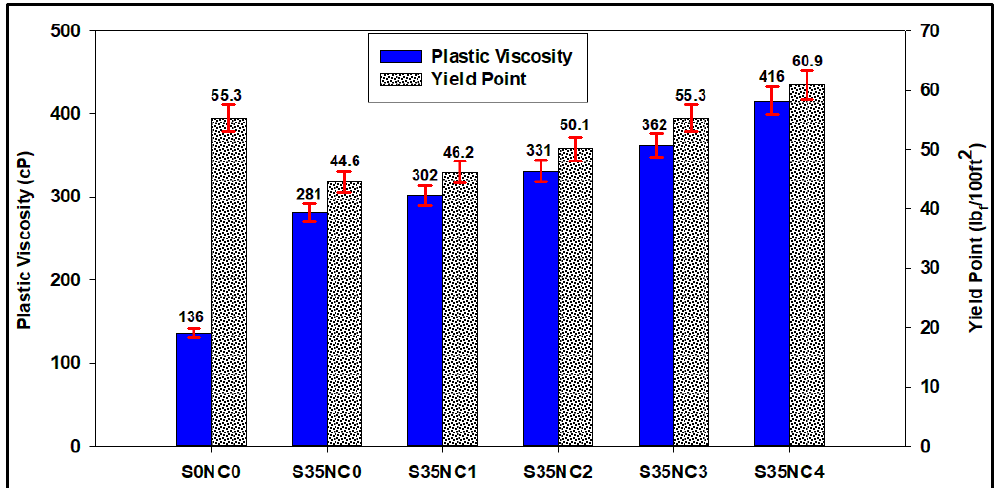
Figure 8. Comparison of the plastic viscosity and yield point for the different cement slurries.